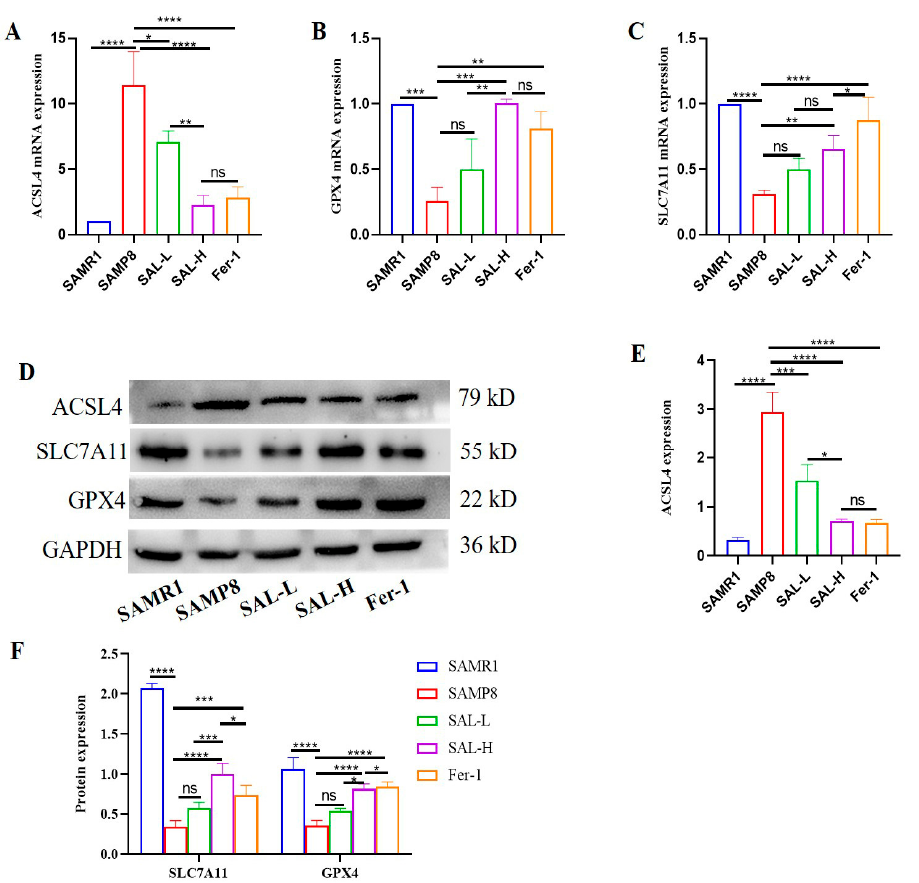
Figure 9. Effects of SAL on the expressions of ACSL4, SLC7A11, and GPX4 in renal tissue of SAMP8 mice (Western blot and q-PCR). ( A ) The relative expression of ACSL4. ( B ) The relative expression of SLC7A11. ( C ) The relative expression of GPX4. ( D – F ) Western blot analysis of ACSL4, SLC7A11, and GPX4 expression, and quantification in the kidney. Data are expressed as means ± SD, * p < 0.05, ** p < 0.01, *** p < 0.001, **** p < 0.0001.